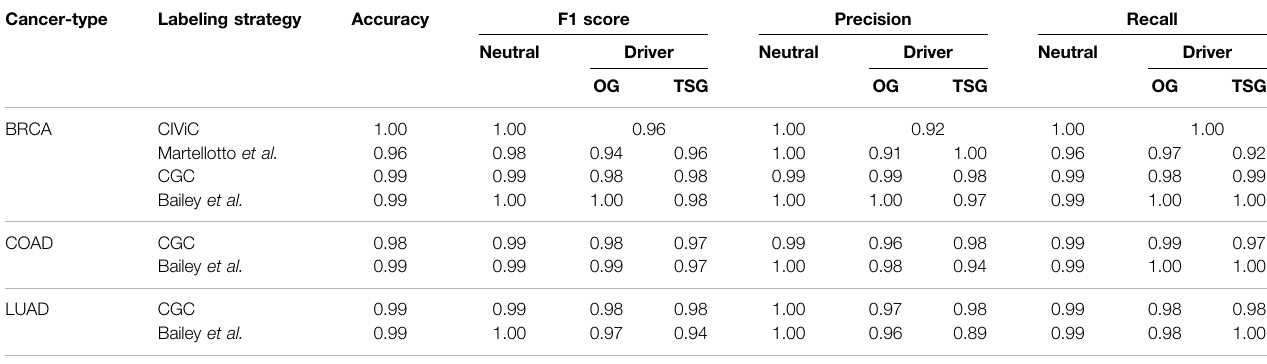
TABLE 3 | Classi fi cation metrics for best RNA models. Cancer-type Labeling strategy